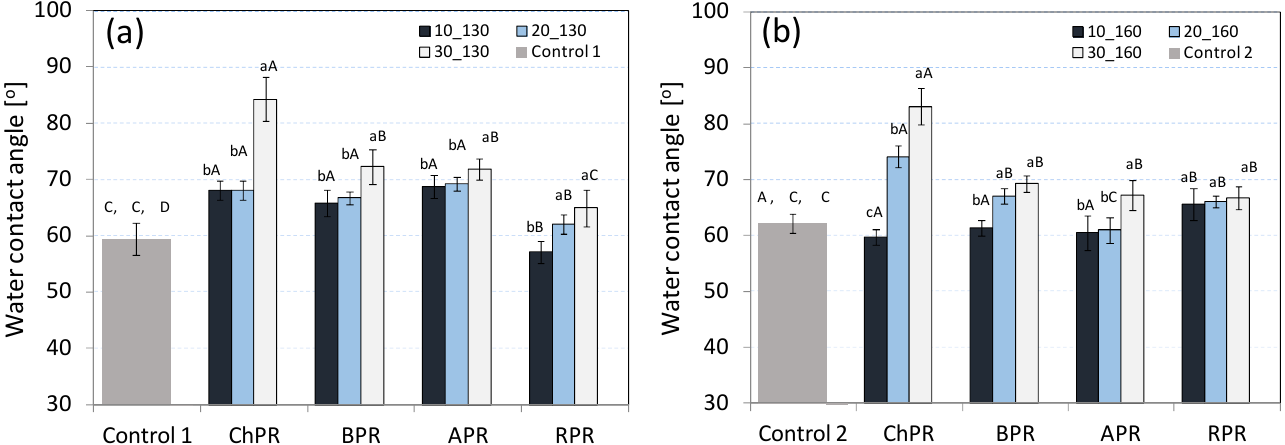
Figure 4. Average water contact angle, for all biocomposites with each share of used pomace: ( a ) sample produced at temperature of 130 °C, ( b ) sample produced at temperature of 160 °C.